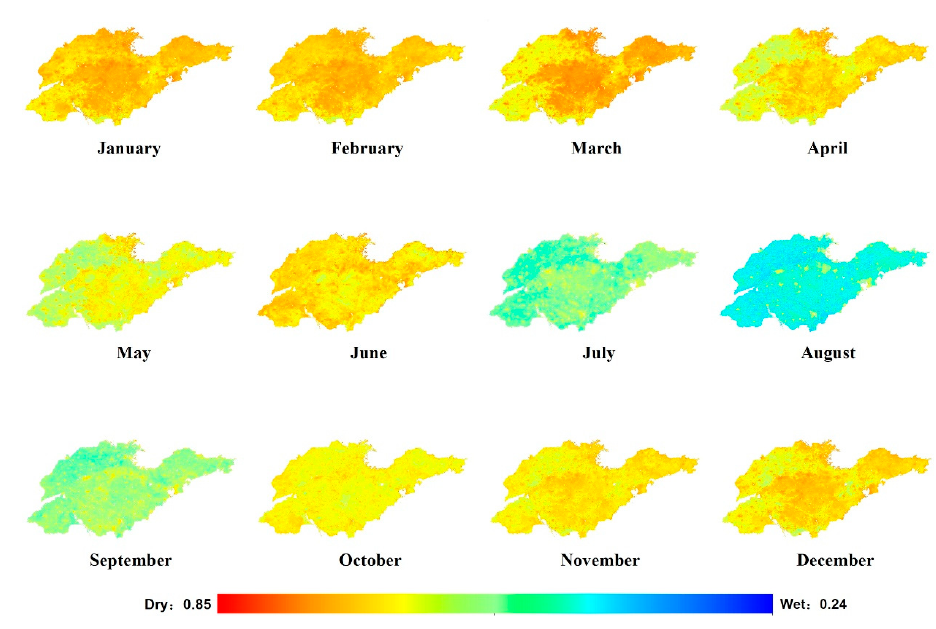
Figure 7. Monthly iTVMDI map of Shandong Province in 2016.